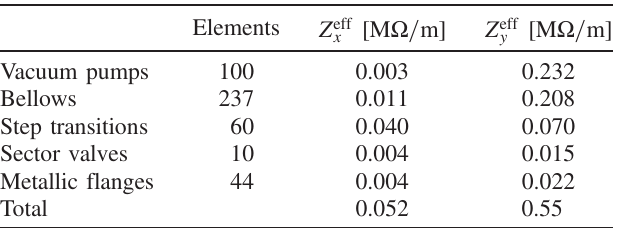
TABLE VI. Effective horizontal and vertical imaginary part of the effective impedances (sum of dipolar and quadrupolar components) for each type of vacuum equipment, computed from CST Particle Studio simulations. The total impedance is scaled by the total number of